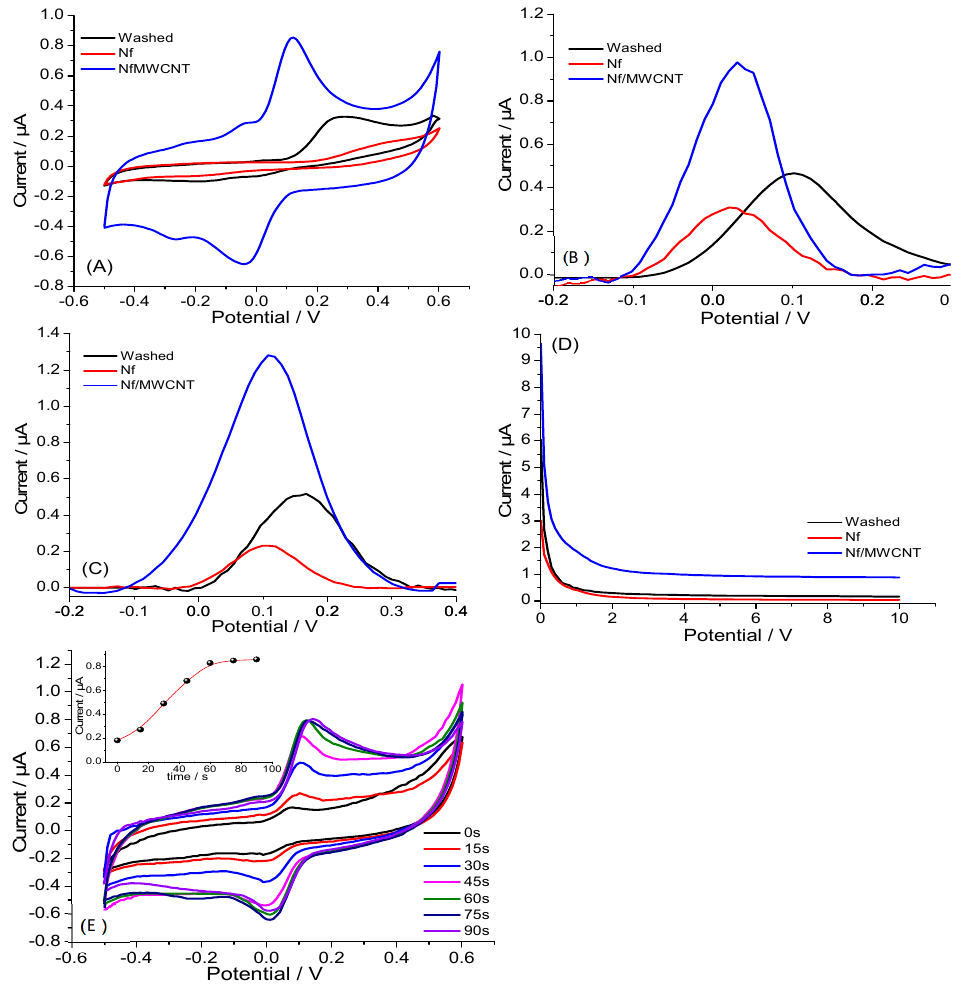
Figure 3. ( A ) CV, ( B ) DPV, ( C ) SWV curves, and ( D ) amperometric response of washed, Nafion (Nf)- and Nf/MWNCT-coated CTSs for 1 µ M Clz; ( E ) the influence of accumulation time on Ipa of 1 µ M Clz using Nf/MWCNTs in PBS (10 mM, pH 7.4) at a scan rate of 100